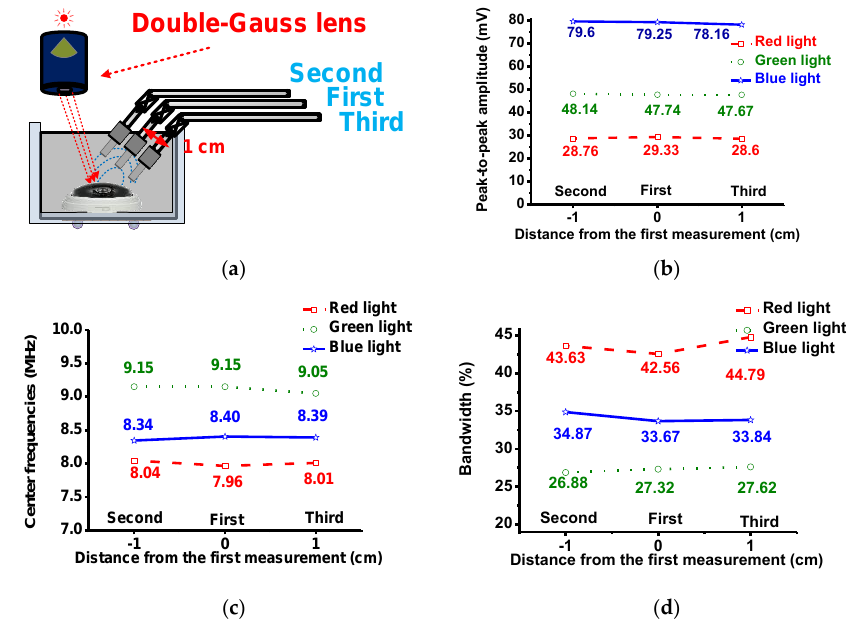
Figure 12. ( a ) Experimental setup when the transducers were placed diagonally in the right side and ( b ) peak-to-peak amplitudes; ( c ) center frequencies; and ( d ) −6 dB bandwidths of the echo signals.